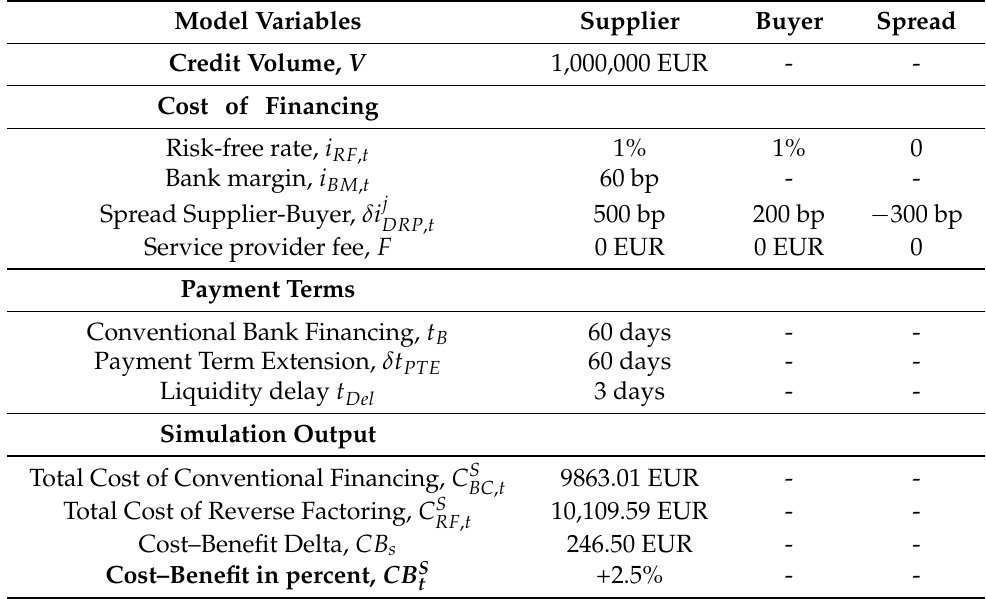
Table 1. Parameter overview of the simulation model. Source: